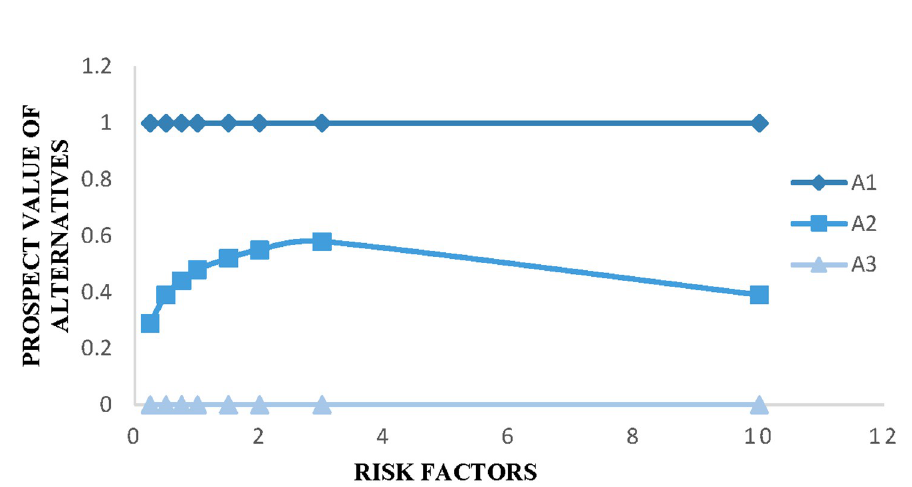
Fig 3. Alternatives’ prospect value of different θ -value for illustrative